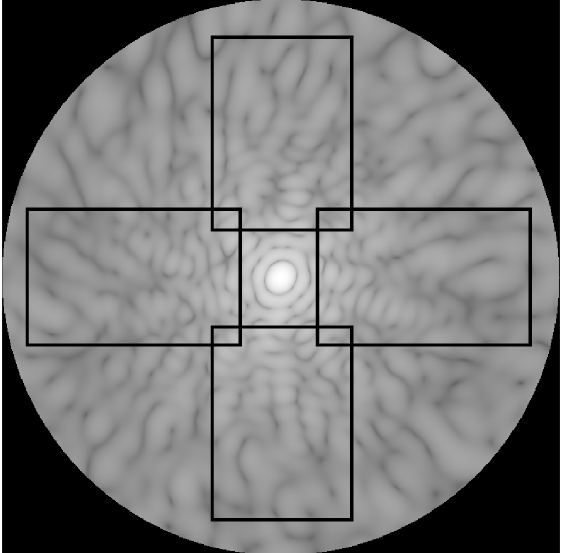
Figure 2. Image of the forward scattering hemisphere showing four regions from which subimage panels were formed. These panels represent regions observed by cameras in experimental work, and provide a good sample of the scattering image. The use of four panels quadrupled the amount of data that was